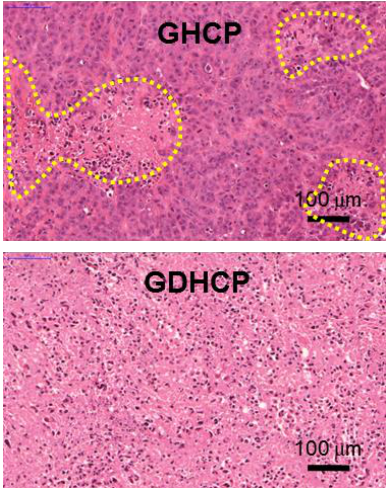
Figure 6. H&E stained slides of cancer tissues extracted from control, cancer bearing, GD-, GHCP- and GDHCP-treated mice after 4 weeks. The slides were observed at 20×. The scale bars indicate 100 µm. The yellow dotted lines indicated necrotic area.